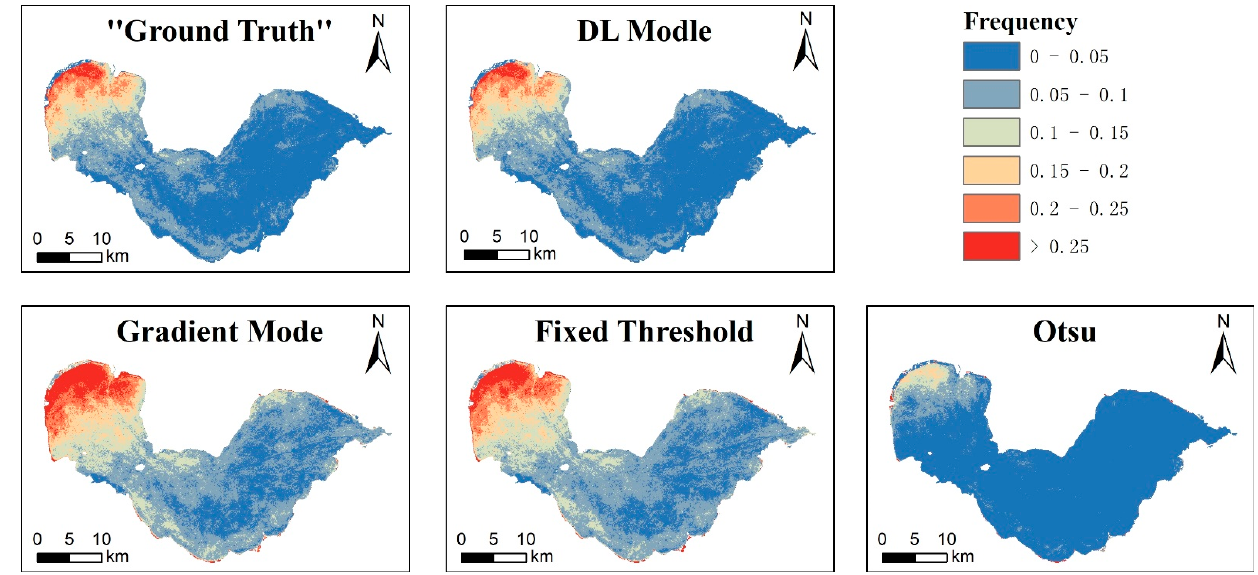
Figure 11. Frequency map between 2016–2020 of the CyanoHABs outbreaks using different methods.